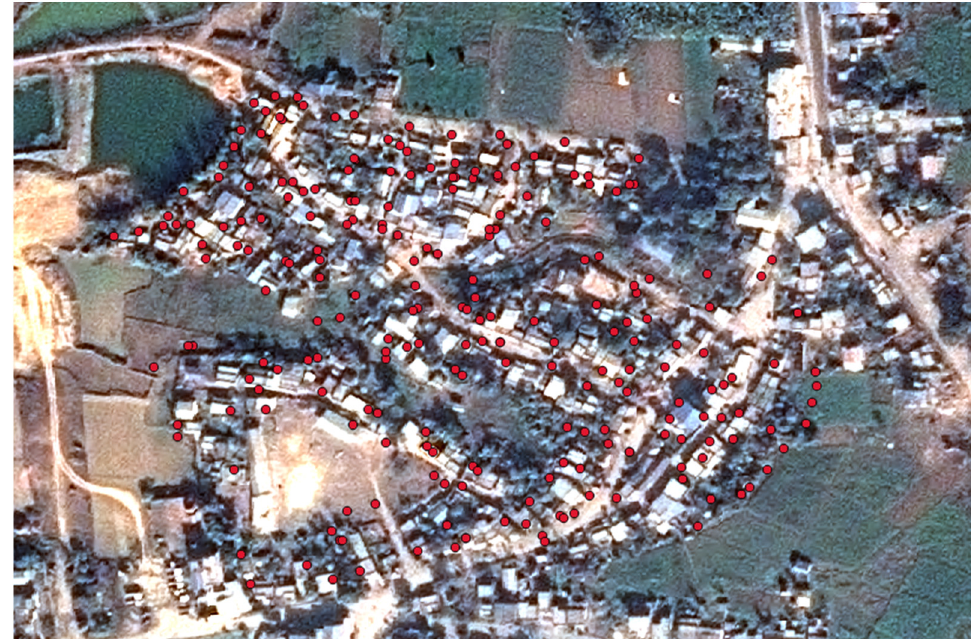
Figure 3. Identification of house/property in one of the compact settlements of Ratnanagar Munici- pality. The individual house location is shown with red-colored dots with satellite imagery in the background.